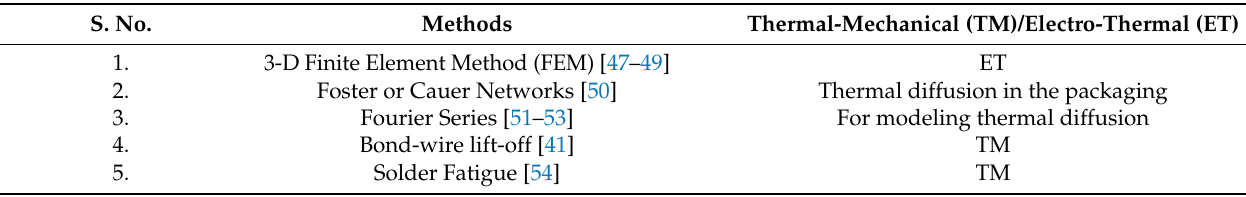
Table 2. Methods for TM And